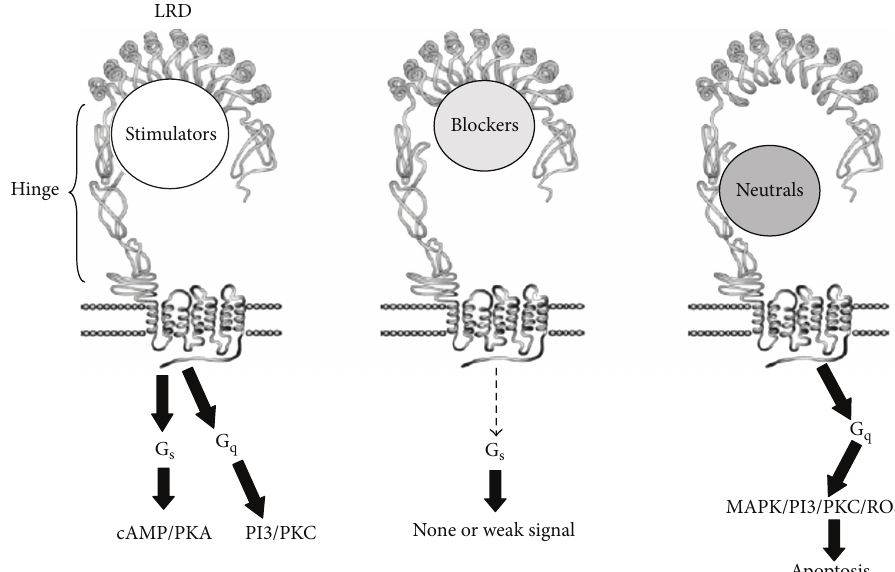
Figure 5: Types of TSH receptor antibodies. Three types of TSH receptor antibodies with their corresponding signal cascades. Adapted from